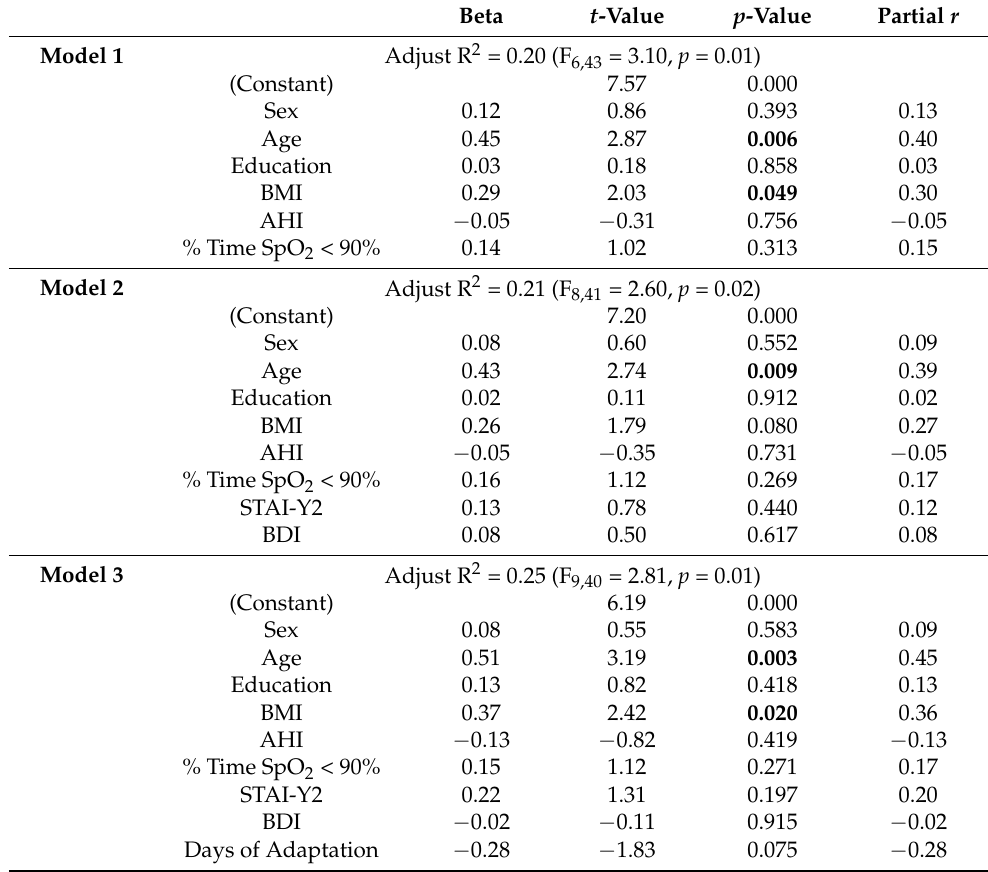
Table 7. Results of the hierarchical multiple linear regression analysis investigating the possible predictors of the efficiency of the executive attention network (i.e., ANT-Ex score *). Adjusted R2 and F-statistics are reported for each model. Standardized Beta, t-values, p -values, and partial r correlation coefficients are reported for each predictor in each model. BMI: body mass index; AHI: apnea-hypopnea index; % Time SpO 2 < 90%: cumulative time spent with peripheral blood oxygen saturation (SpO 2 ) below 90%; STAI-Y2: State-Trait Anxiety Inventory form Y2; BDI: Beck Depression Inventory. * refers to the results relative to to the logarithmic transformation of ANT- Ex scores. Bold means significant results ( p ≤